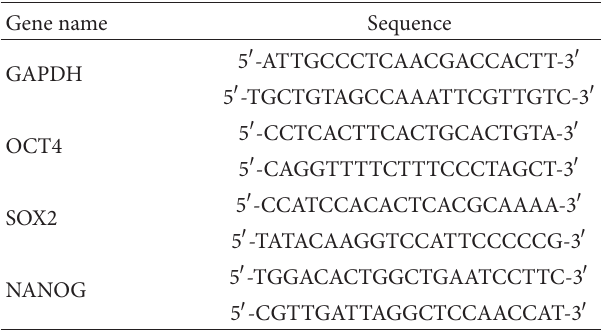
Table 1: Sequence of primers and